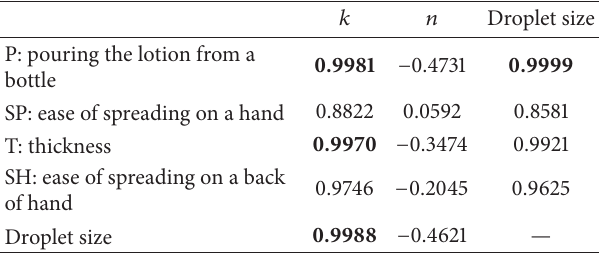
Table 7: Correlation coefficients among rheological and sensory